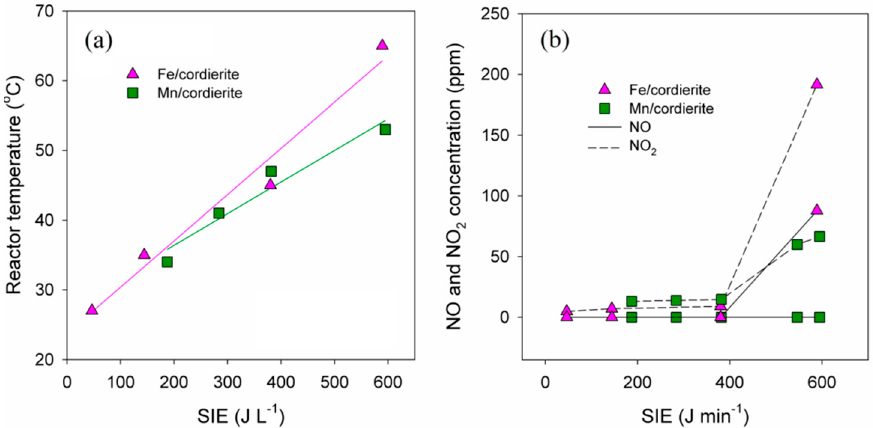
Figure 6. ( a ) Temperature and ( b ) NO and NO 2 concentrations of one-stage reactor with Fe and Mn coated